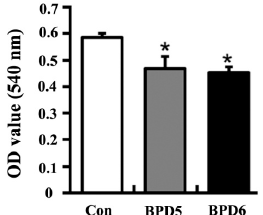
Figure 3. BPDs 5 or 6 inhibit the adhesion of SMMC7721 cells. The cells were seeded on matrigel with 0.5% serum-free RPMI-1640 medium before incubating with BPDs 5 (1.23 μ g/mL) or 6 (0.4 μ g/mL) for 1 h. The cells were washed with 2% bovine serum albumin for 30 min. The remaining cells were stained with crystal violet. The absorbance of OD at 540 nm was detected and recorded with microplate reader. Data represent as mean ± SD ( n = 3). *, p < 0.05 compared with control group.